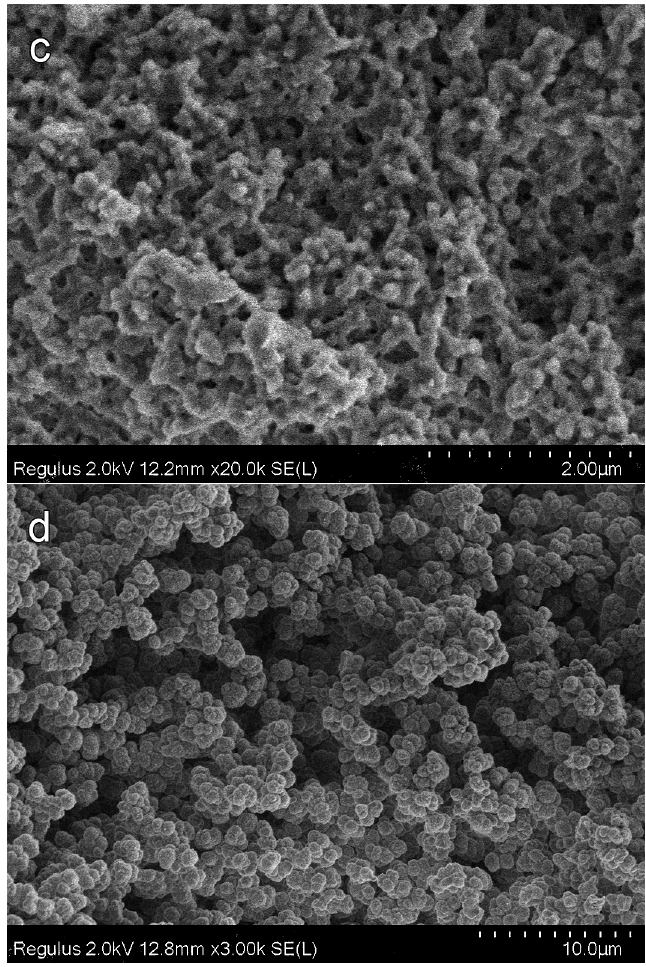
Figure 6. SEM micrographs cleavage surfaces of porous poly-OCM-2 monoliths prepared with various 1-butanol concentrations: ( a , b ) 25% (M8); ( c ) 30% (M9); ( d ) 50% (M12).